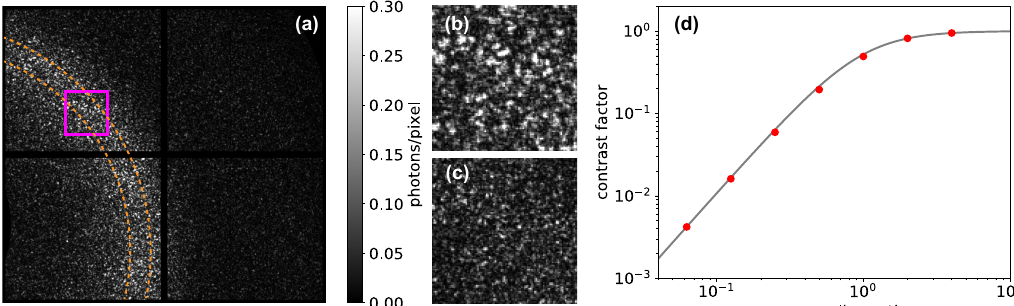
Figure 1. ( a ) Average small-angle coherent scattering from silica nanopowders over 100 consecutive frames. Focused beam size at the sample plane was measured to be 5 µ m. Between the two orange dashed lines is the region of interest (ROI) for contrast extraction. It has a center Q = 0.013 Å − 1 and in total 35035 pixels. ( b ) Enlarged view of the speckle pattern in the area outlined in magenta in ( a ). ( c ) Averaged speckle pattern with focused beam size of 10 µ m showing the same ROI in the scattering as in ( b ). ( d ) The contrast reduction factor as a function of detector sampling. The gray line is from the theoretical calculation and the red dots are from